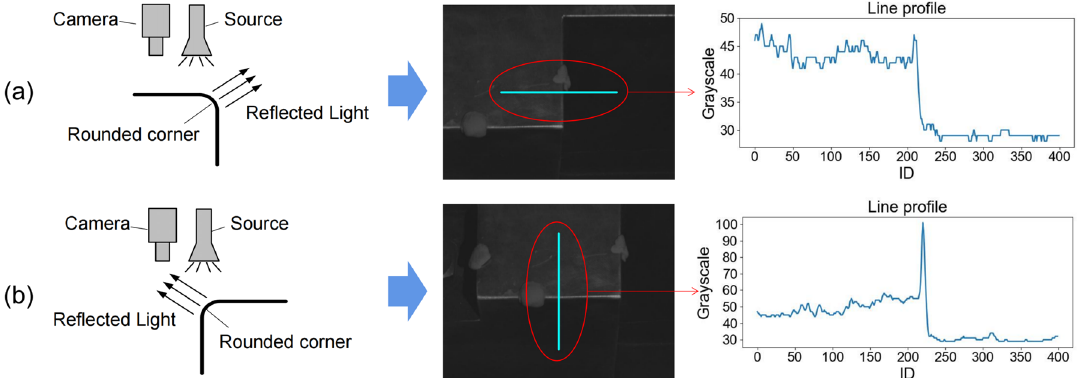
Figure 5. The line profiles of two edge types: ( a ) Weakly illuminated edge; ( b ) Strongly illuminated edge.